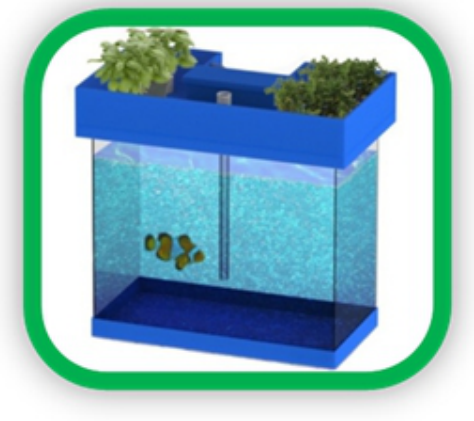
Figure 8. Design of the